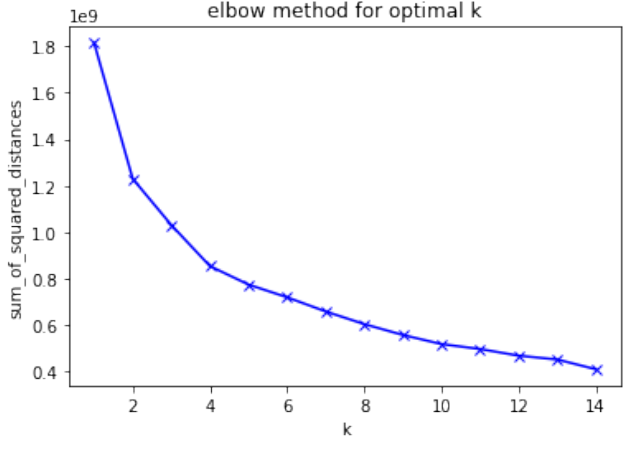
Figure 7. Elbow curve for optimal